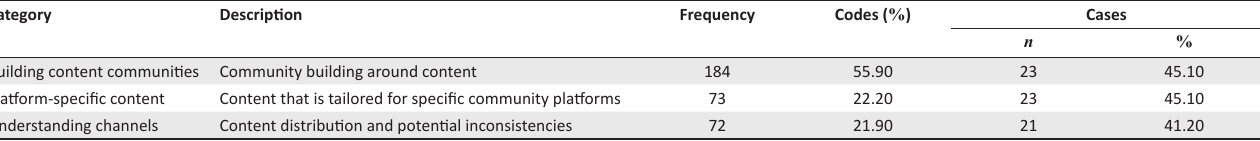
TABLE 1: The three main categories and frequency in the data.